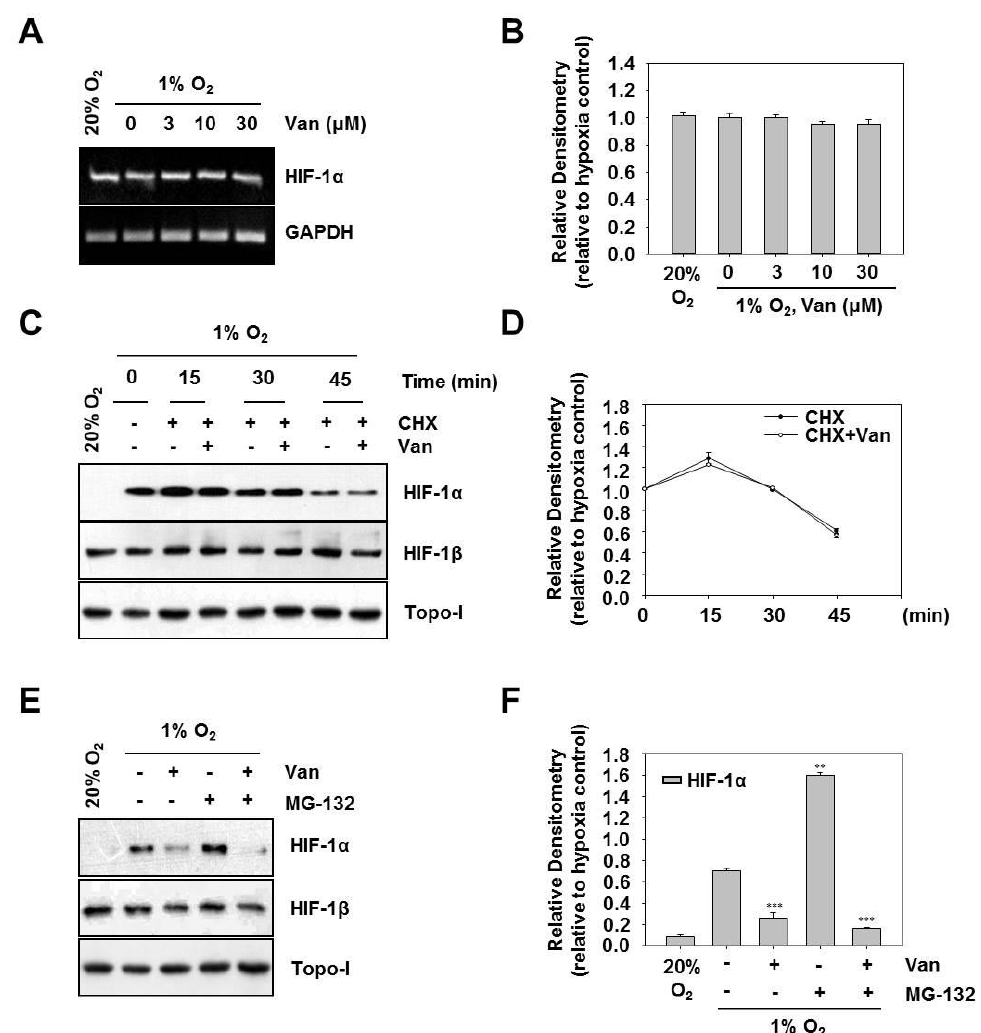
Figure 3. Vanillic acid (Van) inhibits the protein synthesis of HIF-1 α but not its degradation. ( A ) HCT116 cells were pretreated without or with indicated concentration of vanillic acid (Van), then cultured under normoxic or hypoxic conditions for 12 h. Total RNA was analyzed by RT-PCR as described in “Materials and Methods”. ( B ) Data were shown as mean ± SD ( n = 3). ( C ) HCT116 cells were first treated under hypoxia for 4 h. Then cells were incubated in the presence of cycloheximide